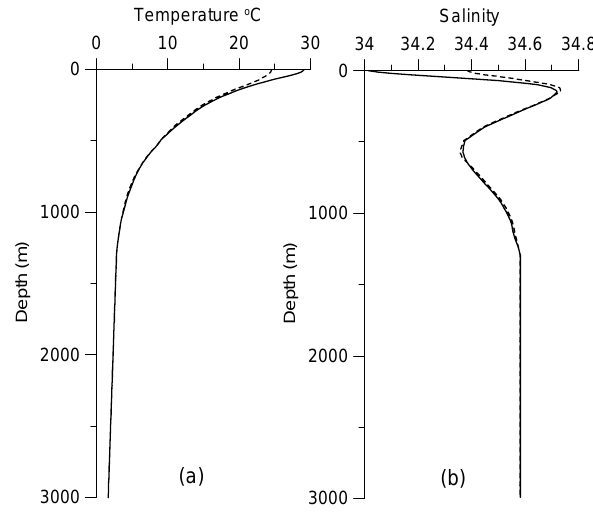
Fig. 2. Averaged temperature (a) and salinity (b) profiles for sum- mer (solid lines) and winter (dashed lines) seasons used in mod-